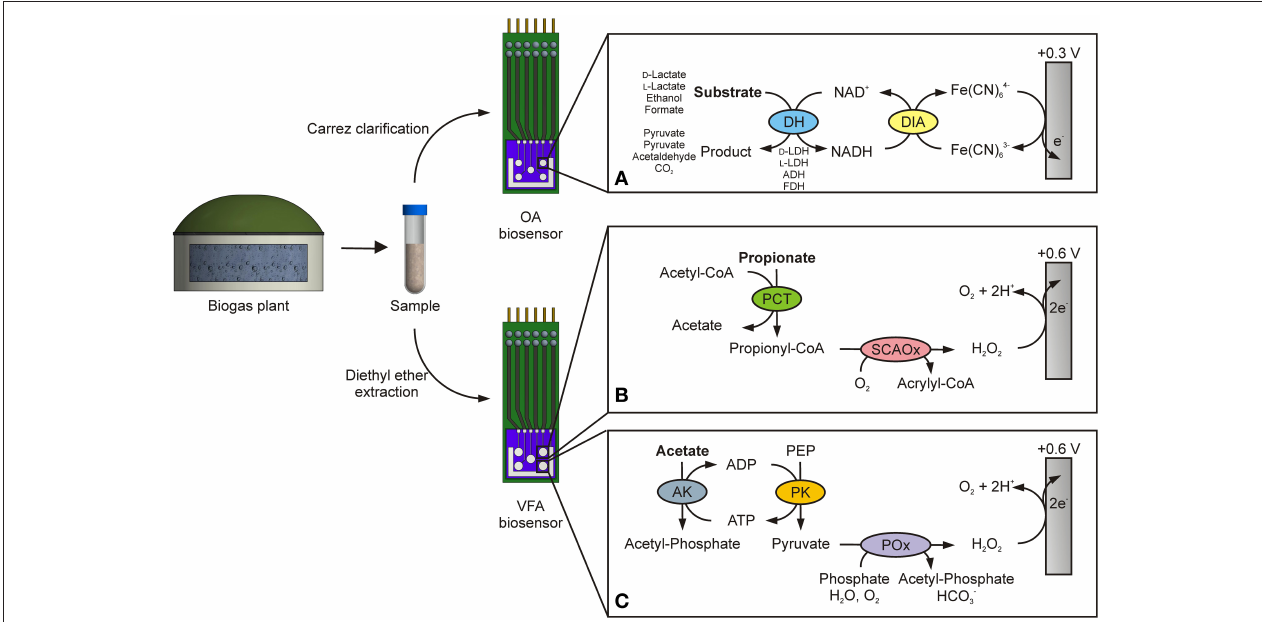
FIGURE 1 | Amperometric detection principles of the organic acid (OA) and volatile fatty acid (VFA) biosensor. A sample of fermentation broth is taken from a biogas plant and pretreated by either Carrez clarification or ether extraction. (A) Determination of ethanol, formate, D - and L -lactate is then realized by using a bi-enzymatic system, consisting of a specific dehydrogenase (DH) and diaphorase (DIA). For simultaneous detection, on each working electrode DIA with a different DH is immobilized, namely D -lactate dehydrogenase ( D -LDH), L -lactate dehydrogenase ( L -LDH), alcohol dehydrogenase (ADH) and formate dehydrogenase (FDH), respectively. The product Fe(CN) 64 − is re-oxidized at an applied potential of +0.3 V vs. Ag/AgCl. The oxidation of H 2 O 2 at a working potential of +0.6 V vs. Ag/AgCl is used for measurement of propionate (B) and acetate (C) . For propionate quantification, propionate CoA-transferase (PCT) and short-chain acyl-CoA oxidase (SCAOx) are used. Combination of acetate kinase (AK), pyruvate kinase (PK) and pyruvate oxidase (POx) enable amperometric detection of